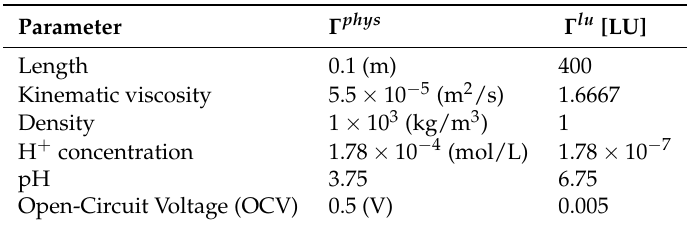
Table 2. Main physical parameters for the MFC reactor and their LU conversions.